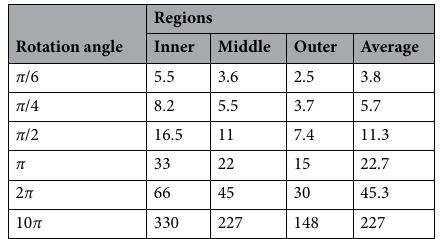
Table 1. The equivalent strain after t -HPS (rotation angle π/6 ~ 10π) at different observation regions.